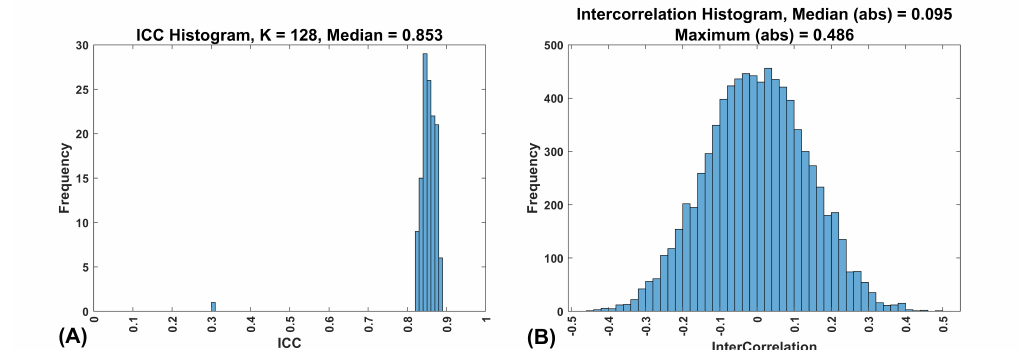
Figure 3. Characteristics of the FaceNet features. ( A ) This is a frequency histogram of the ICCs for the 128 FaceNet features. All of the features are between 0.8 and 0.9, which corresponds exactly with our synthetic Band 8 features. This indicates that these features are very reliable over time. ( B ) This is a frequency histogram of the intercorrelations of the 128 FaceNet features.